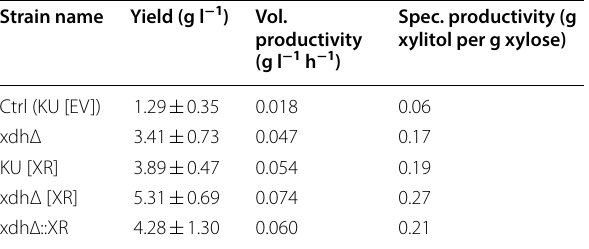
Table 3 Yields (after 72 h growth on 20 g l − 1 glucose and 20 g l − 1 xylose) and productivities of the strains used in this